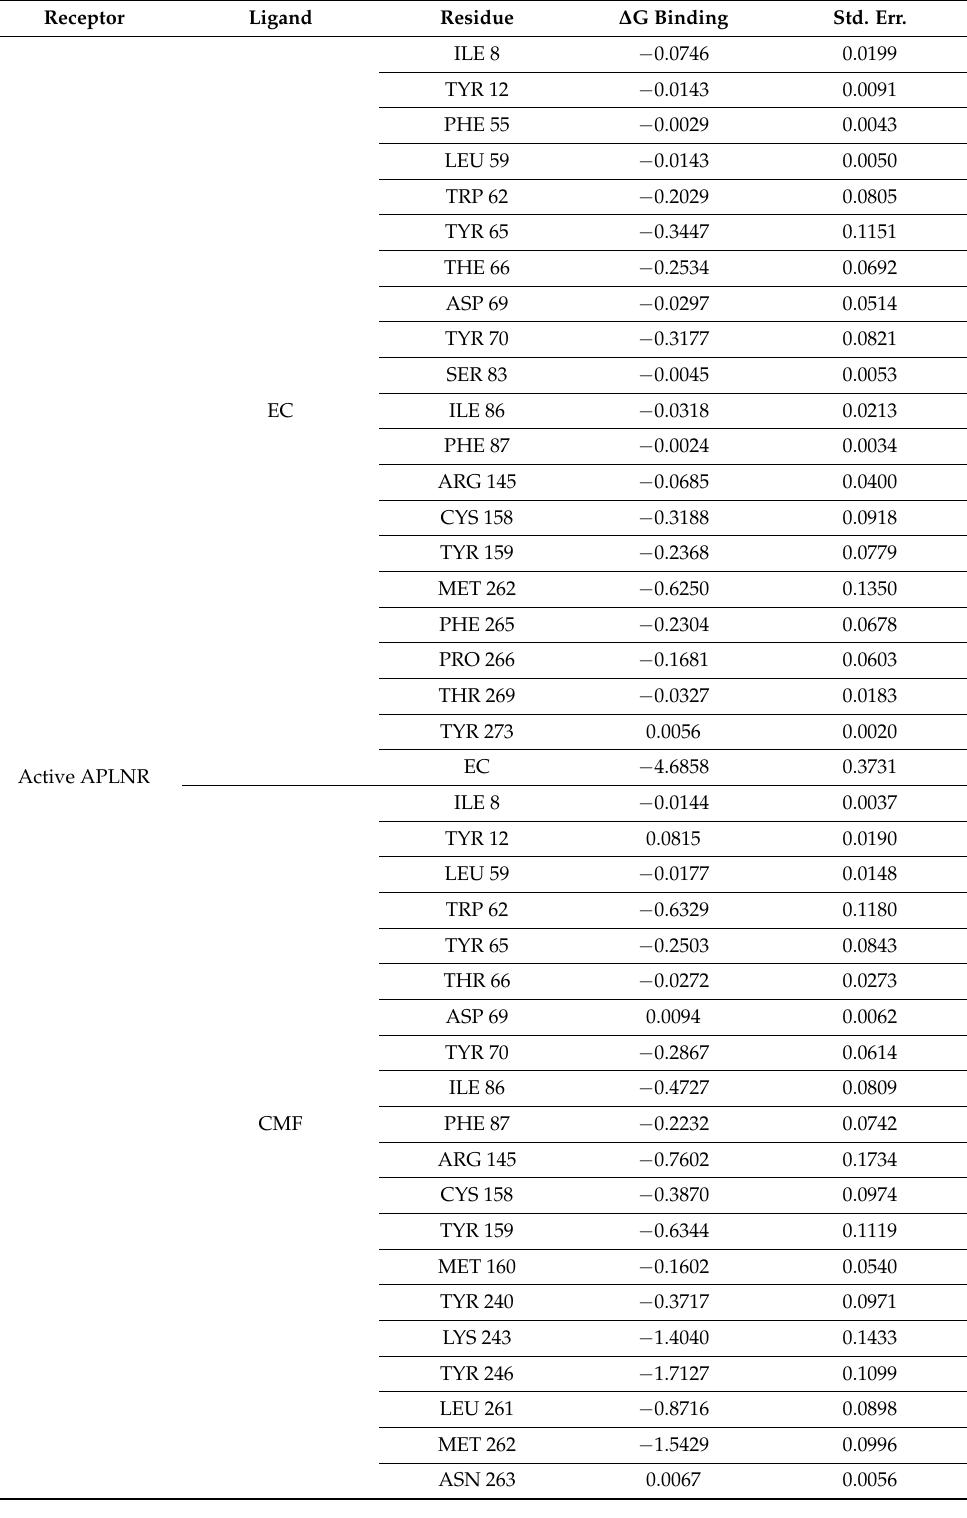
Table 7. Ligand and residue energetical contribution to global free binding energy calculated by MM/GBSA